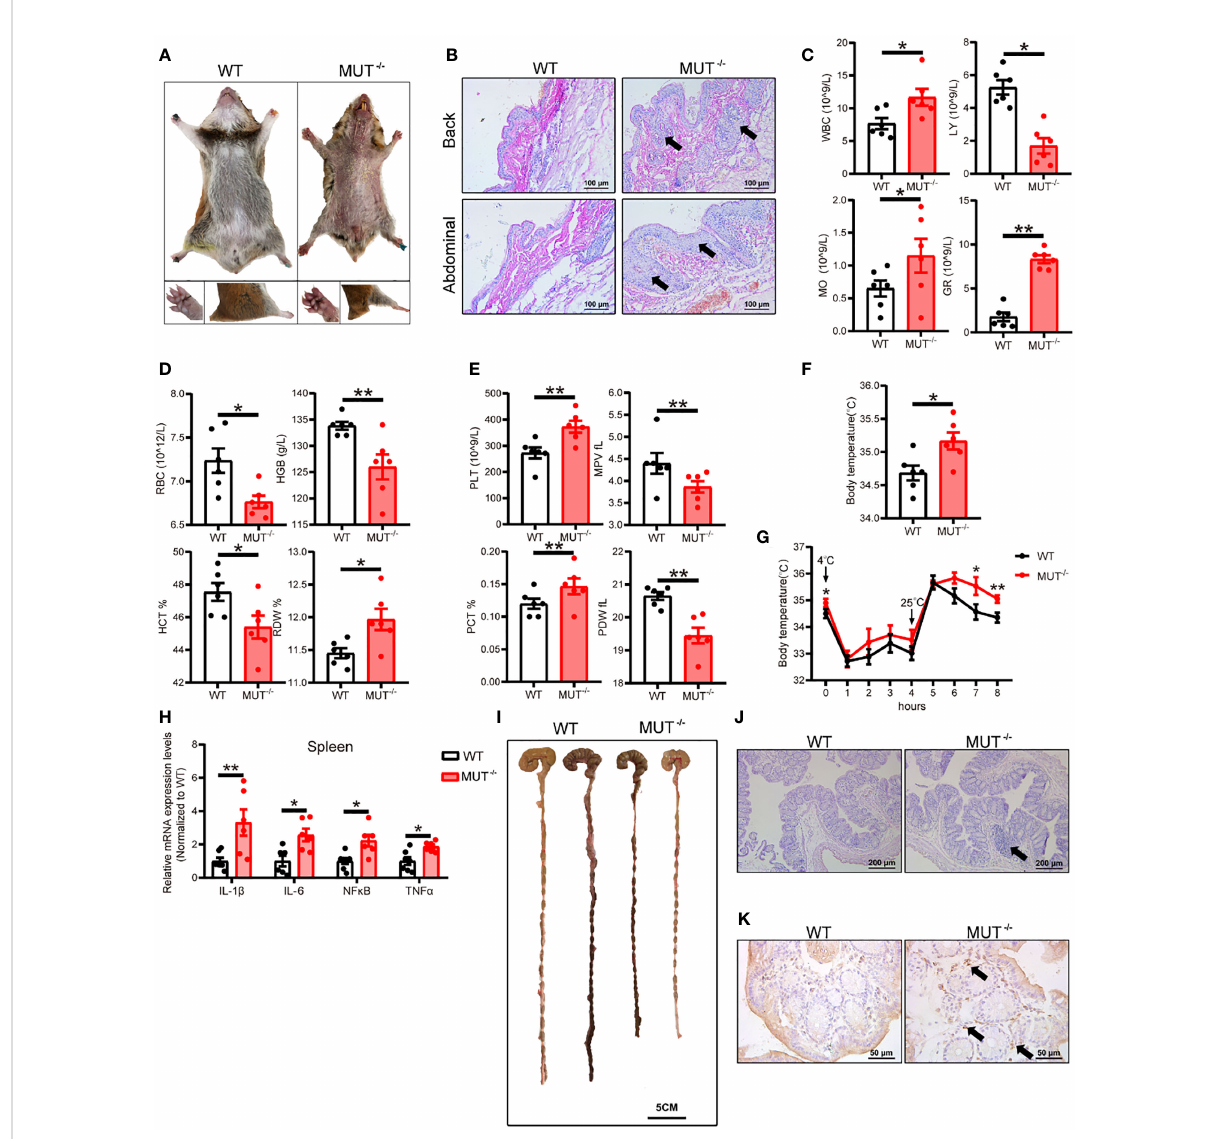
FIGURE 2 IL-10 MUT/MUT hamsters on a regular chow diet exhibited severe spontaneous systemic in fl ammation. (A) Representative images of 3-months old male WT and IL-10 MUT/MUT hamsters on chow diet. (B) Skin at the Back and abdominal areas of WT and IL-10 MUT/MUT hamsters was stained with HE. Bars: 100 m m; arrows indicate immune cell in fi ltration. (C, D and E) The blood biochemical characteristics of WT and IL-10 MUT/MUT hamsters (n=6/group). (F) Body temperature of WT and IL-10 MUT/MUT hamsters (n=6/group). (G) Body temperature curve of WT and IL-10 MUT/MUT hamsters exposed to different stimuli (n=6/group). (H) Expression levels of proin fl ammatory markers in spleen were determined by real-time PCR (n=6/group). (I) Representative images of colon tissue from WT and IL-10 MUT/MUT hamsters. Bars: 5 cm. (J) Morphological analysis of colons stained with HE for WT and IL-10 MUT/MUT hamsters. Bars: 500 m m; arrows indicate immune cell in fi ltration (K) Immunohistochemistry of CD68 in the colons from WT and IL-10 MUT/MUT hamsters. Bars: 50 m m; arrows indicate positive staining. All data were expressed as means ± SEM, *p<0.05;